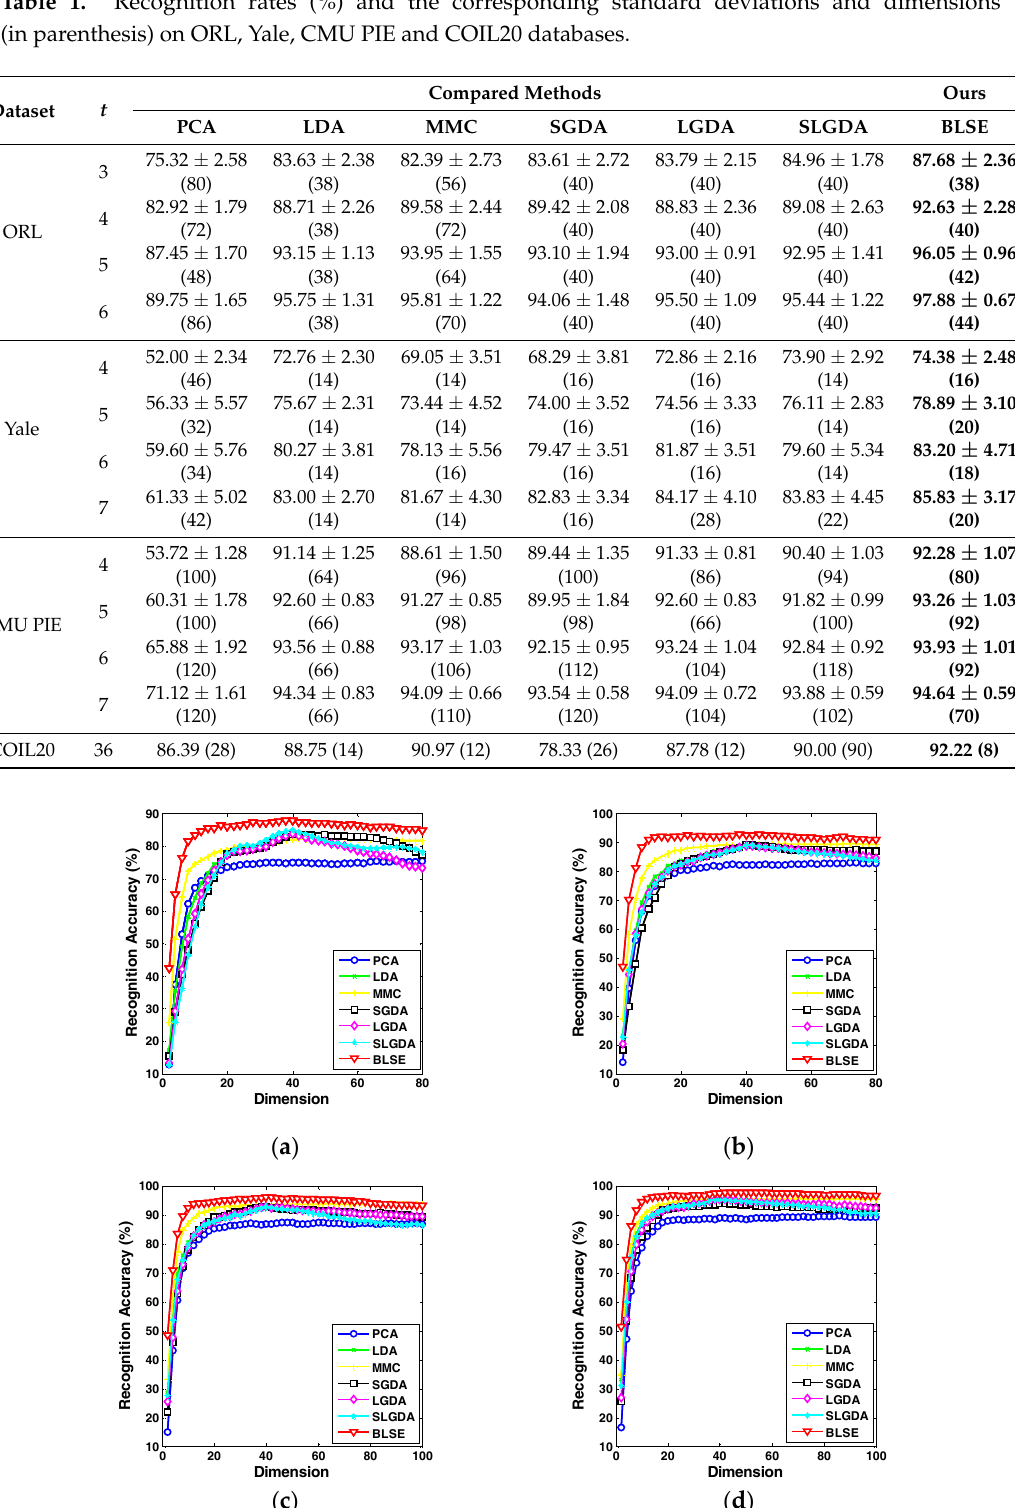
( d ) Figure 10. Recognition rate (%) versus dimension of different methods on the Yale dataset. ( a ) Four training samples per person; ( b ) Five training samples per person; ( c ) Six training samples per person; ( d ) Seven training samples per person.